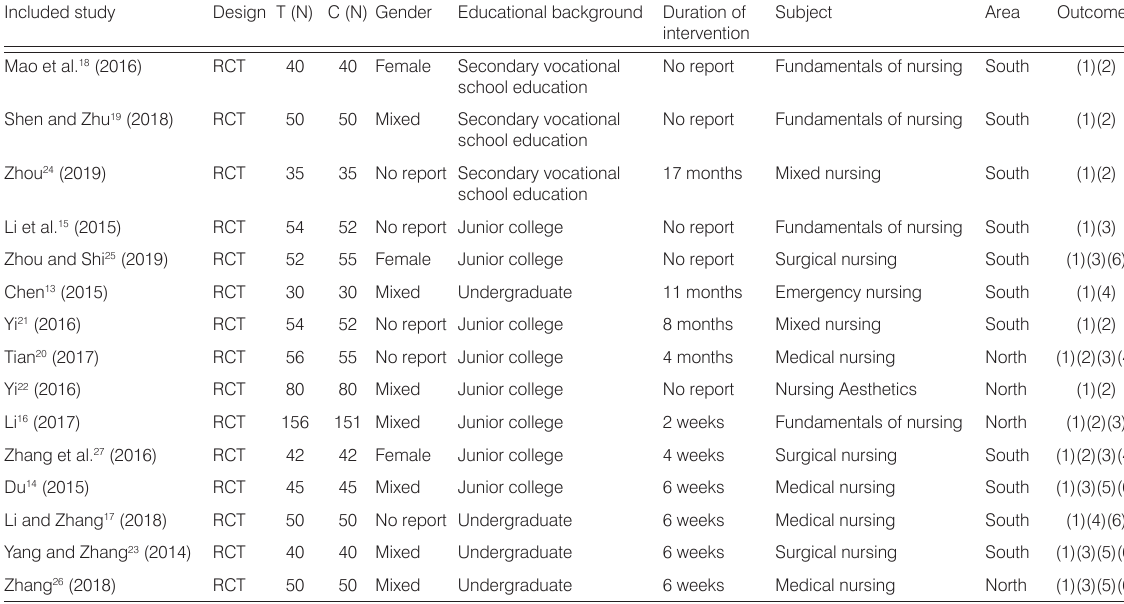
Table 1. Characteristics of the 15 studies of the effect of the experiential teaching method on nursing students’ education.